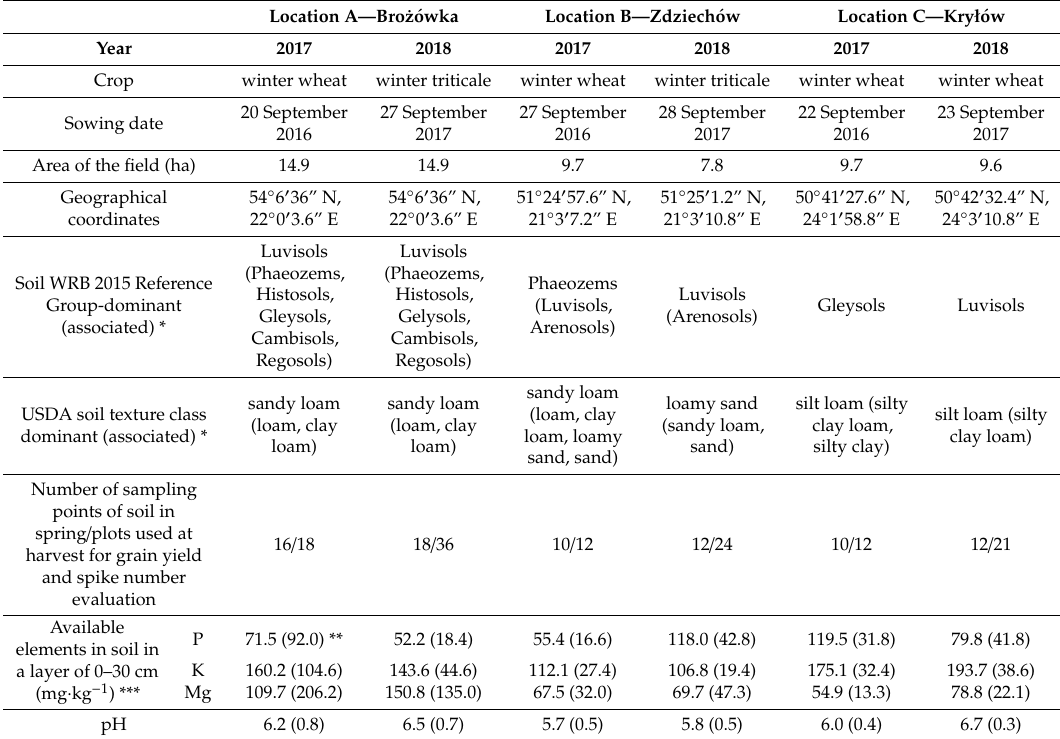
Table 1. Characteristics of the studied fields in three locations and in two years.